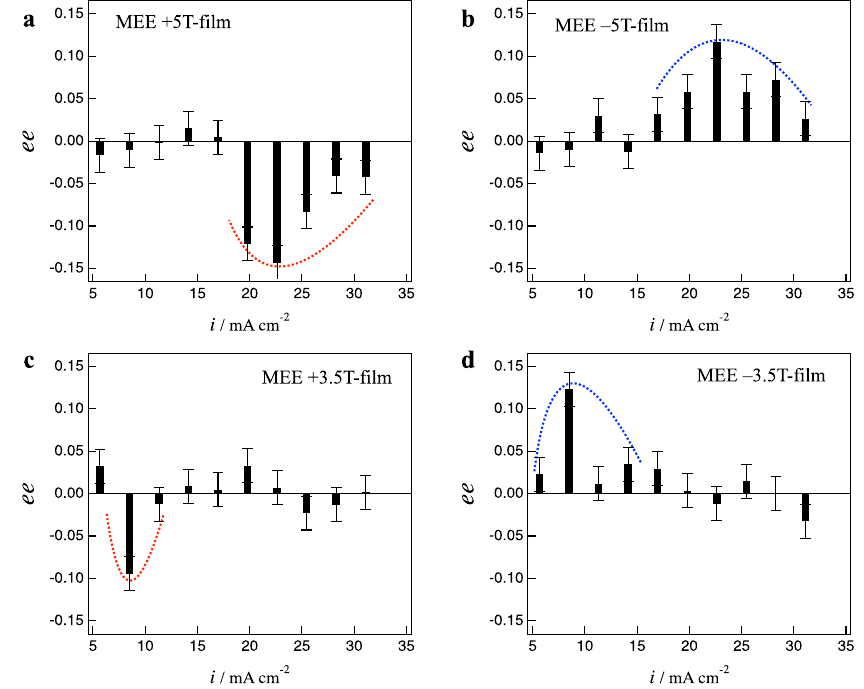
Figure 5. The ee ratios vs. etching currents. ( a ) MEE + 5T-film, ( b ) MEE − 5T-film, ( c ) MEE + 3.5T-film and ( d ) MEE − 3.5T-film. Dotted curves are a guide for the eye.